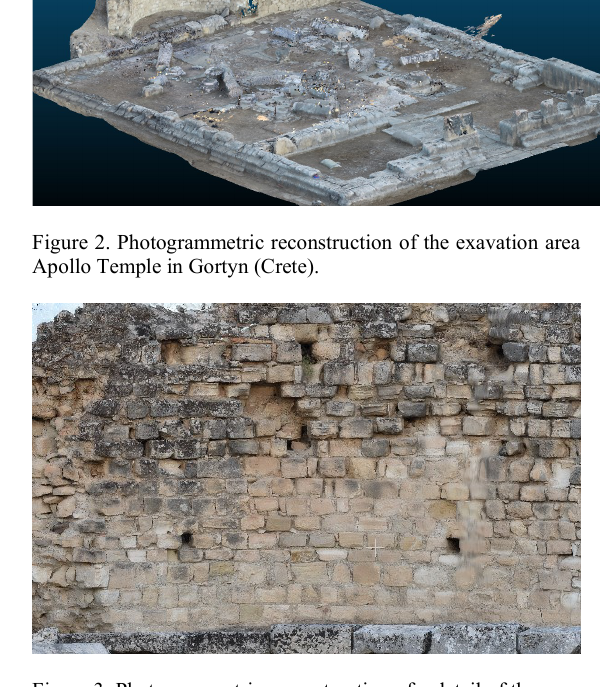
Figure 3. Photogrammetric reconstruction of a detail of the apse of the temple.